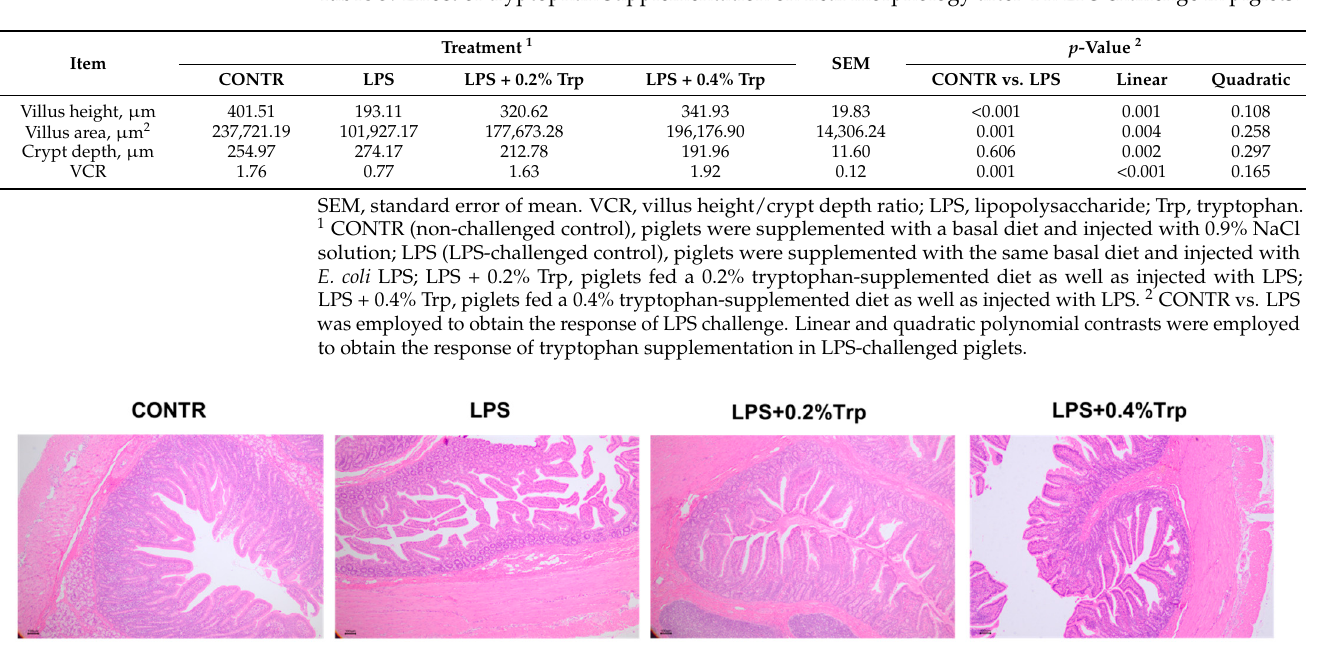
Table 3. Effect of tryptophan supplementation on ileal morphology after 4 h LPS challenge in pig- lets.